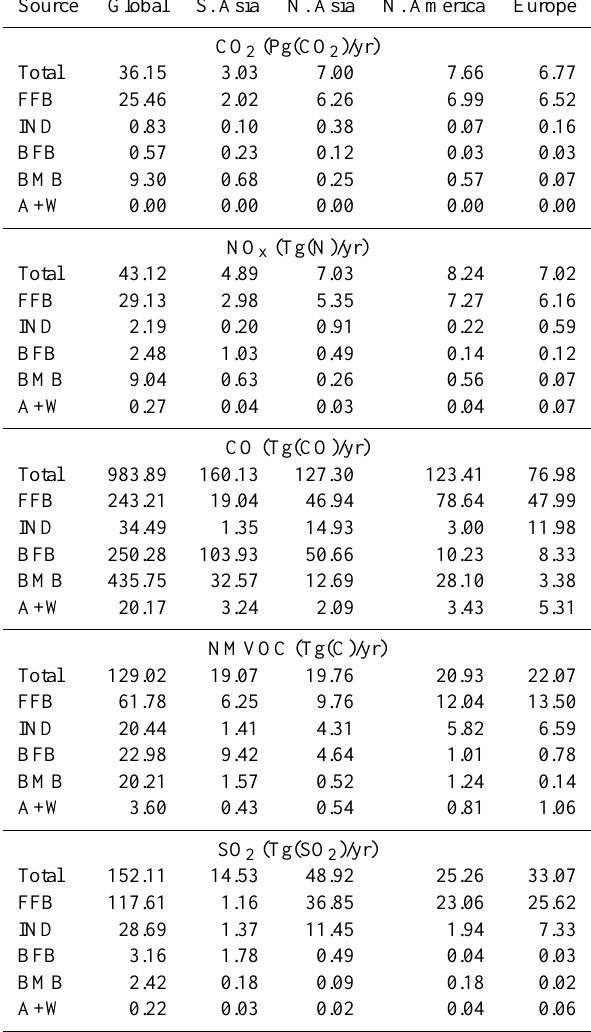
Table 2. Emissions of key trace gases segregated by source category for the world, for southern Asia, and for three other key emissions regions in the NH (depicted in Fig. 1). The source categories are: FFB – Fossil Fuel Burning (including shipping emissions within the defined regions, but excluding emissions from aircraft); IND – in- dustrial processes; BFB – biofuel burning; BMB – biomass burning; A+W – agricultural processes and waste handling (including waste burning). The units are specified individually for each gas. Data is from the EDGAR 3.2FT2000 database (Olivier et al., 2005); see the text for